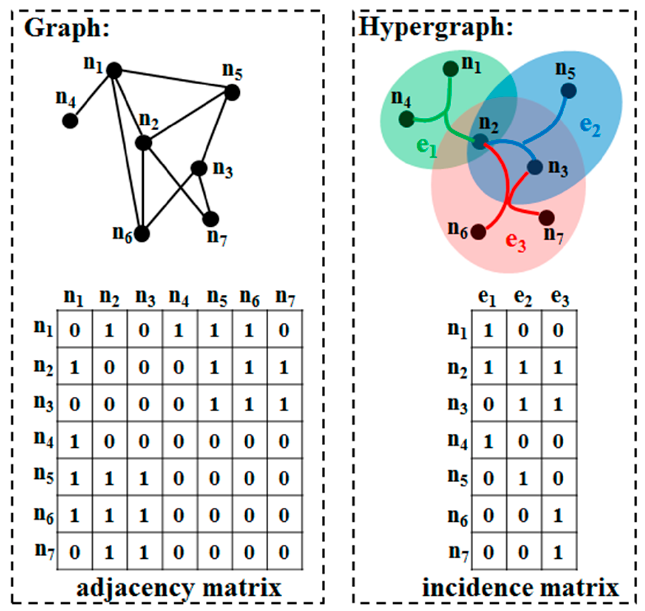
Figure 1. An example of ordinary graph and hypergraph.